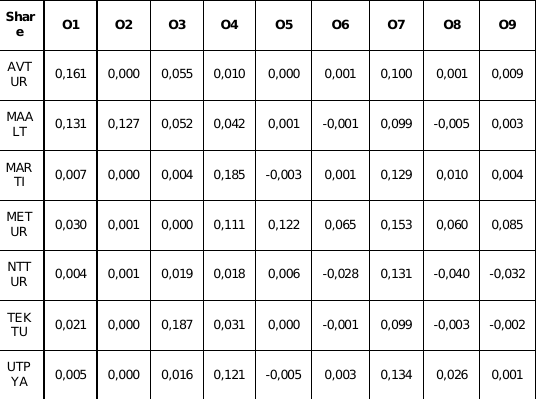
Table 10: Year 2013 Weighted Normalized Decision Matrix